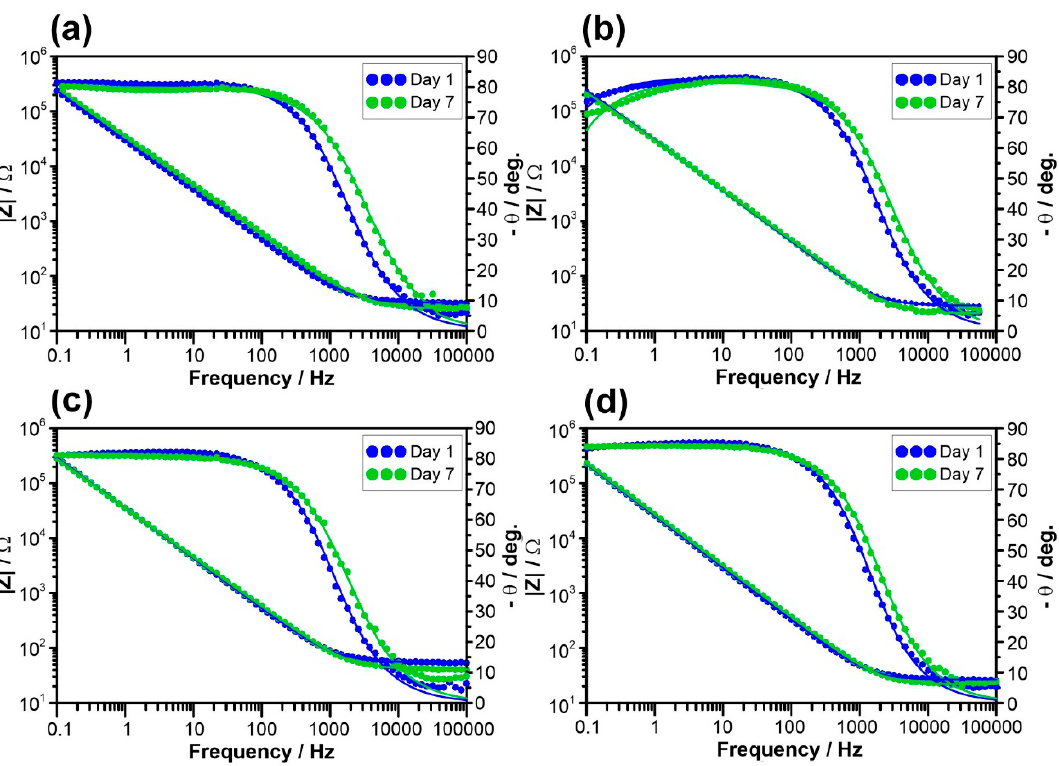
Figure 6. Bode impedance plots on Days 2 and 7 of exposure, recorded for: ( a ) pure Ti; and three tested alloys: ( b ) TC21; ( c ) Ti-6Al-4V; and ( d ) Ti-6Al-7Nb. Studies performed at E corr in 0.9%NaCl solution at 37 °C. Points represent experimental results while the solid line was calculated based on R(QR) EEC.